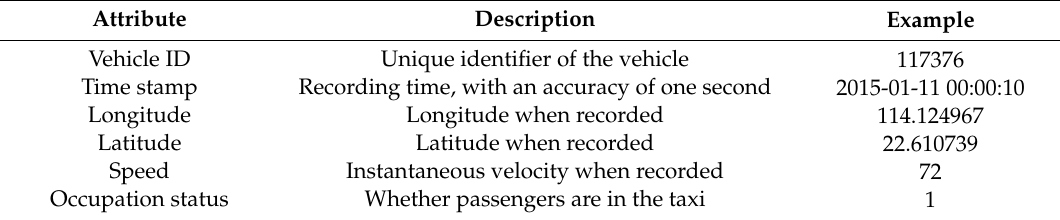
Table 1. Description of the raw taxi GPS data.